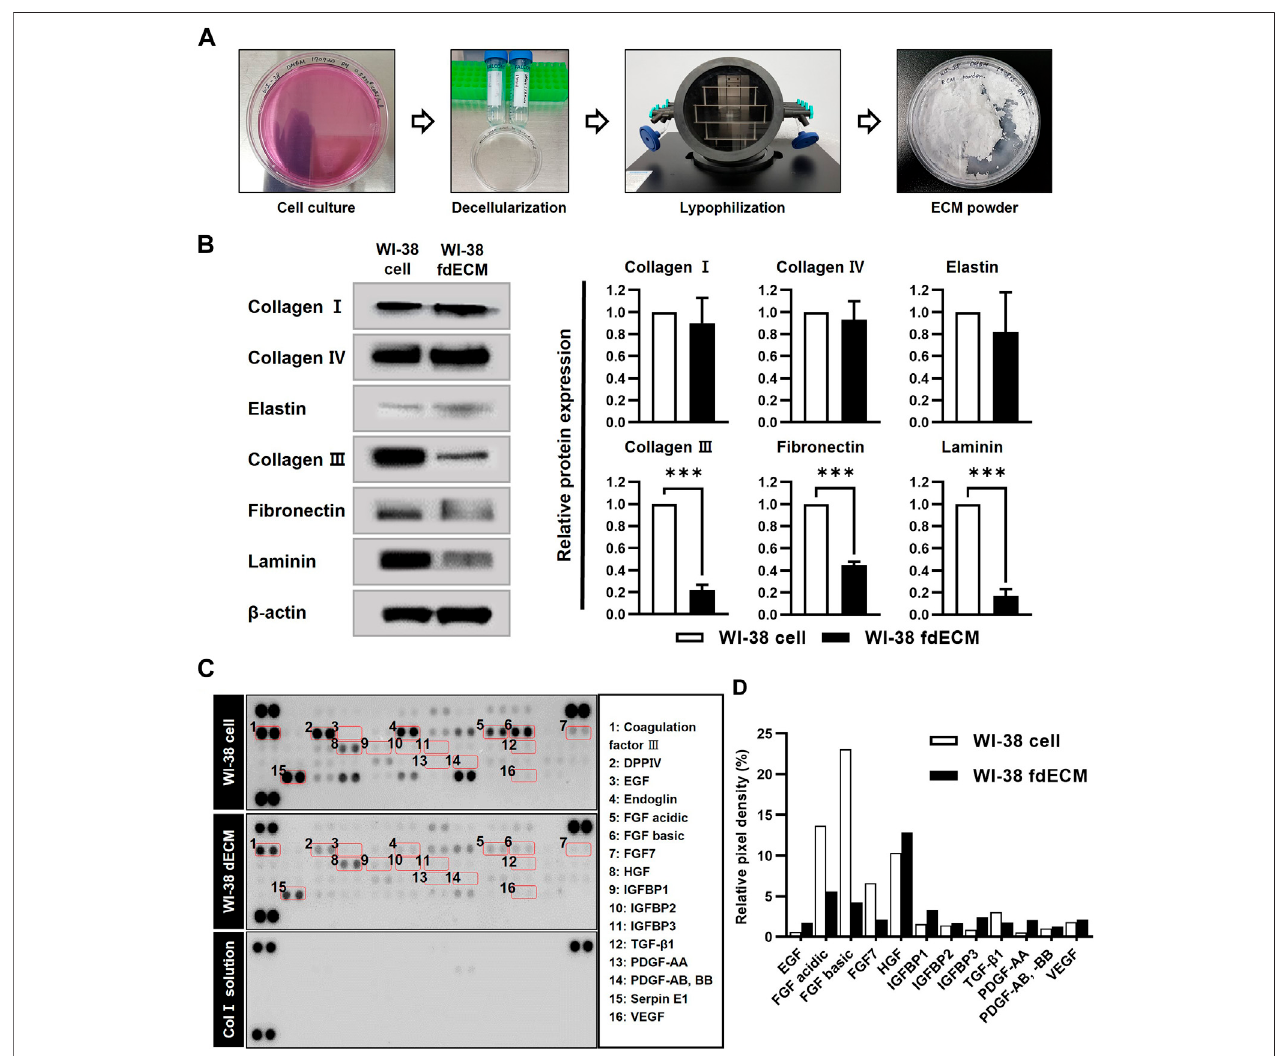
FIGURE 1 | Preparation and characterization of fdECM. (A) The extraction method of WI-38 fi broblast-derived decellularized extracellular matrix (fdECM). (B) Western blot analysis of ECM proteins before and after decellularization with β -actin as an internal control. (C) Analysis of angiogenic factors by a semi-quantitative method. Dot blot of the matrix before and after decellularization. The graph of some of the 55 principal angiogenic factors detected (box denotes factors). Results are expressed as mean ± standard deviation (SD). *** p < 0.001.